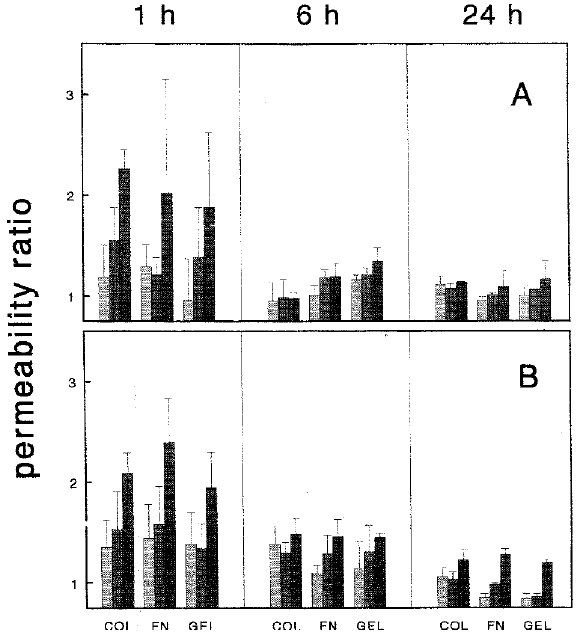
FIG. 5. Permeability of LPS-treated HUVEC monolayers. The increase in permeability to albumin (panel A) and dextran (panel B) is expressed as the permeability ratio (± SD, n = 4) between treated and untreated monolayers. In panels, from left to right, the permeability ratio of monolayers cultured on collagen (COL), fibronectin (FN) and gelatin (GEL), after 1, 6 and 24h of diffusion is shown. Open bars: 50ng/ml LPS; grey bars: 500ng/ml LPS; black bars: 10 m g/ml